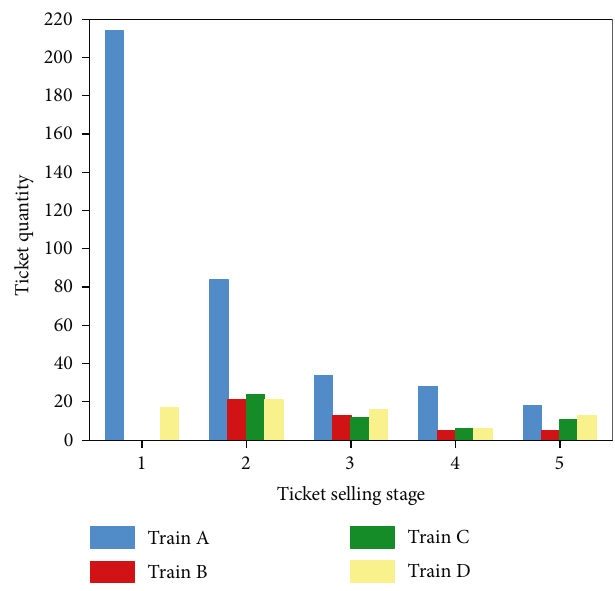
Figure 8: Ticket allocation quantity for OD pair